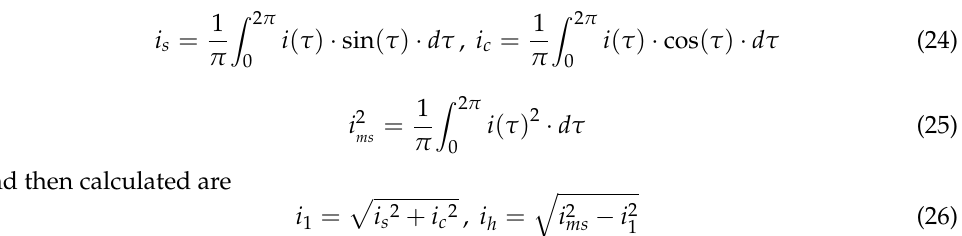
Figure 3. Voltage and current waveforms of the circuit model with nonlinear load and voltage observer for u a = 0.6, r = 0.1.